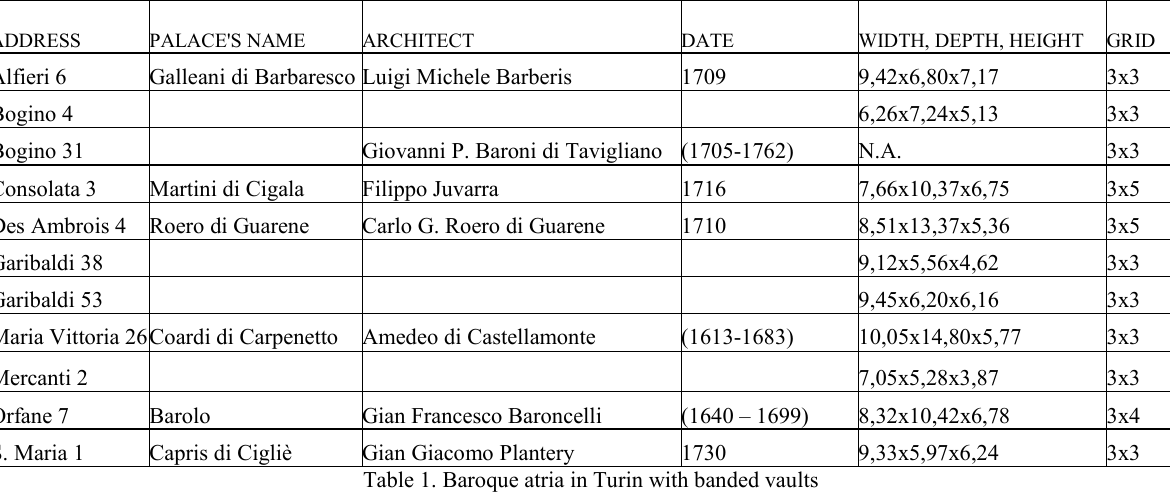
Table 1. Baroque atria in Turin with banded vaults